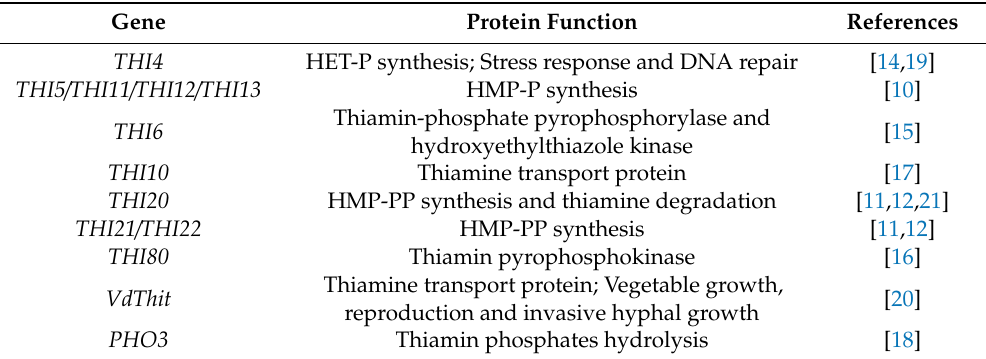
Table 1. Genes involved in thiamine